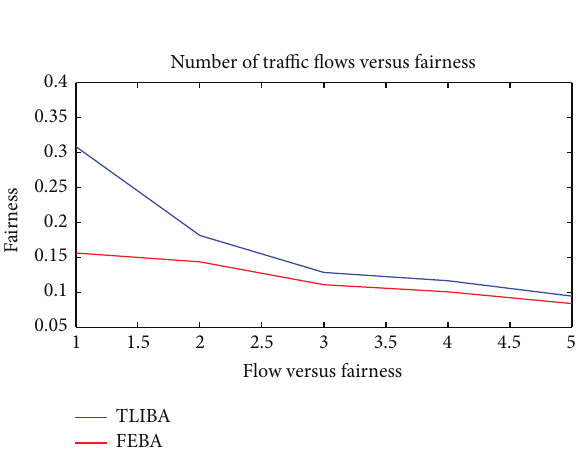
Figure 3: Flow versus received bandwidth.